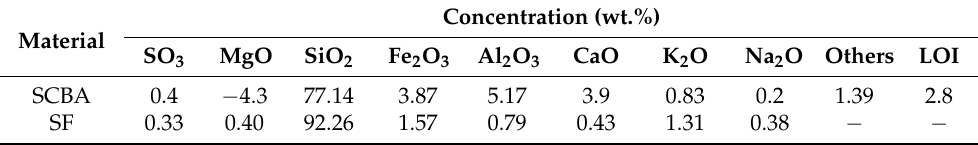
Table 3. Chemical composition of SCBA and SF obtained by XRF.